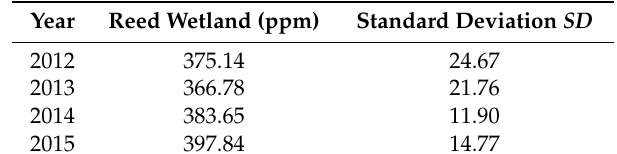
Table 2. CO 2 concentration characteristics.